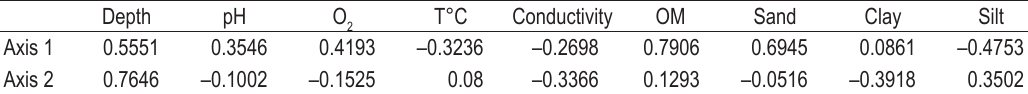
Table 3. Inter set correlation values of environmental variables with the fisrt two axes of CCA. Depth pH Conductivity